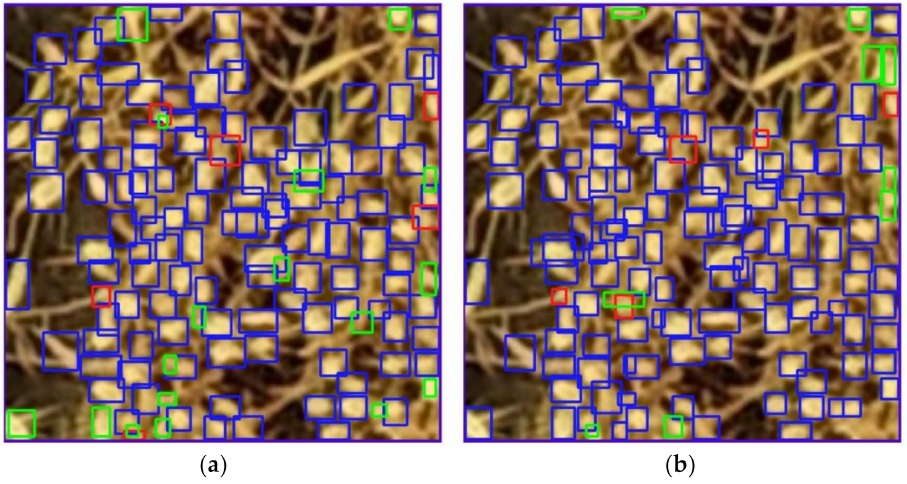
Figure 9. Detection results using the default anchor setting ( a ) and the prior anchor setting by k -means cluster ( b ). Blue boxes represent the correct-detected wheat spikes, red boxes represent the error-detected wheat spikes, and green boxes represent the undetected wheat